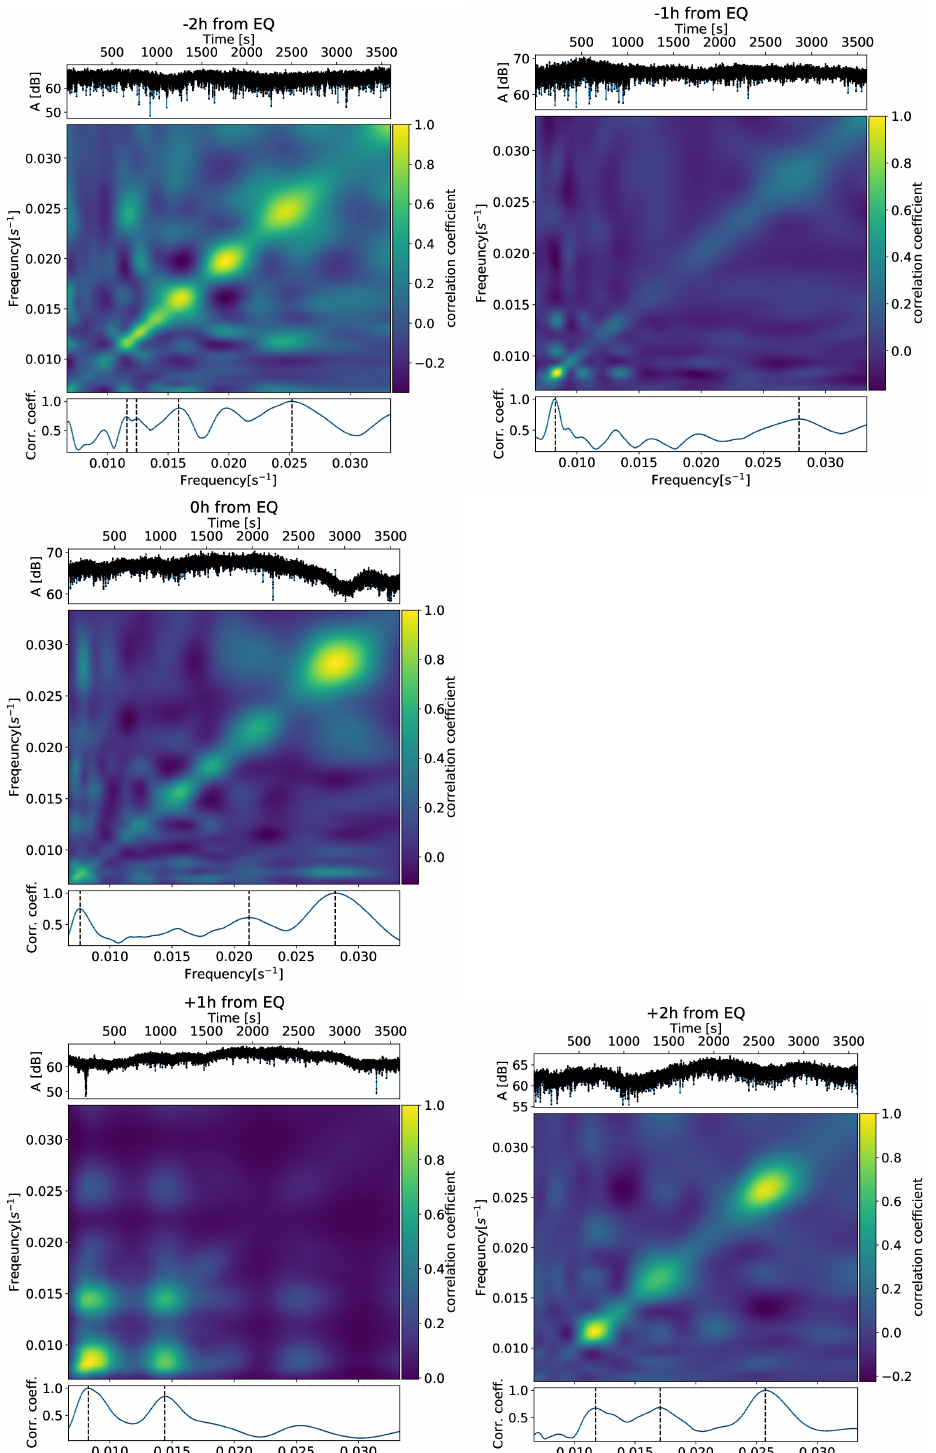
Figure 2. 2D Hybrid maps of oscillations in VLF signal amplitude data. Each plot shows a portion of the time series relative to the beginning of the earthquake (top marginal panel), a 2D Hybrid map (middle panel), and a projected 2D Hybrid map (bottom marginal plot), the color bar represents correlation coefficients on map. Top row: time series 2 h before earthquake (left) and 1 h before earthquake (right); middle row: 0 h from earthquake; bottom row: 1 h after earthquake (left) and 2 h after earthquake